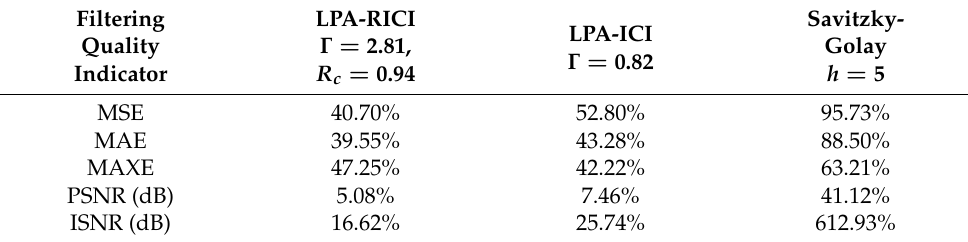
Table 39. Sing signal (SNR = 5 dB)—Filtering quality improvement of the RBF-RICI-based filtering over other tested algorithms.